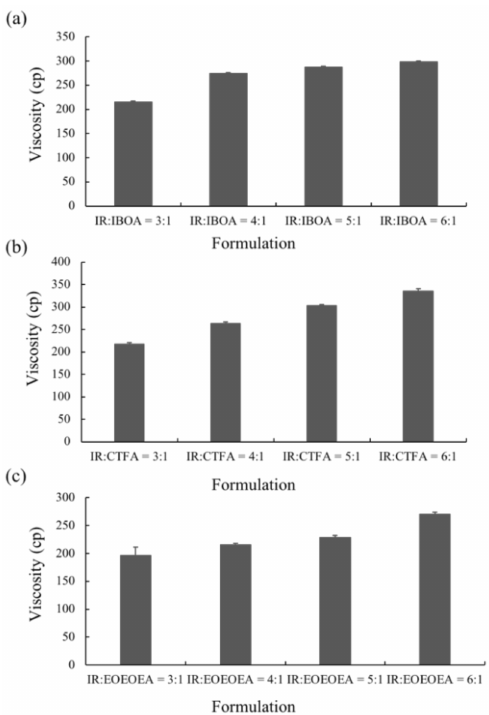
Figure 1. The viscosity of various proportions of cis -1,4 polyisoprene (IR) and diluent monomer formulations. ( a ) IR/IBOA, ( b ) IR/CTFA, ( c ) IR/EOEOEA. The ratios of polyisoprene (IR) and diluent monomers are 3:1, 4:1, 5:1, and